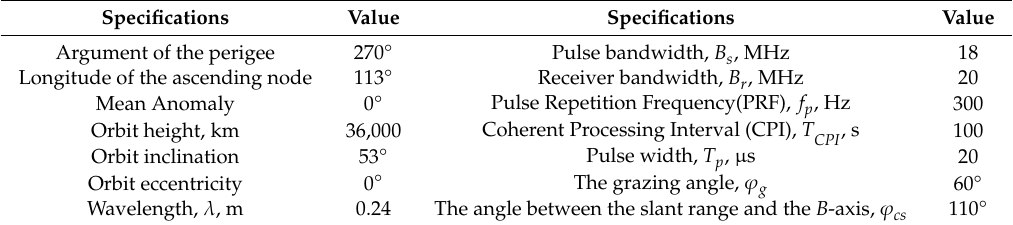
Table 1. The system parameters of GEO SAR.